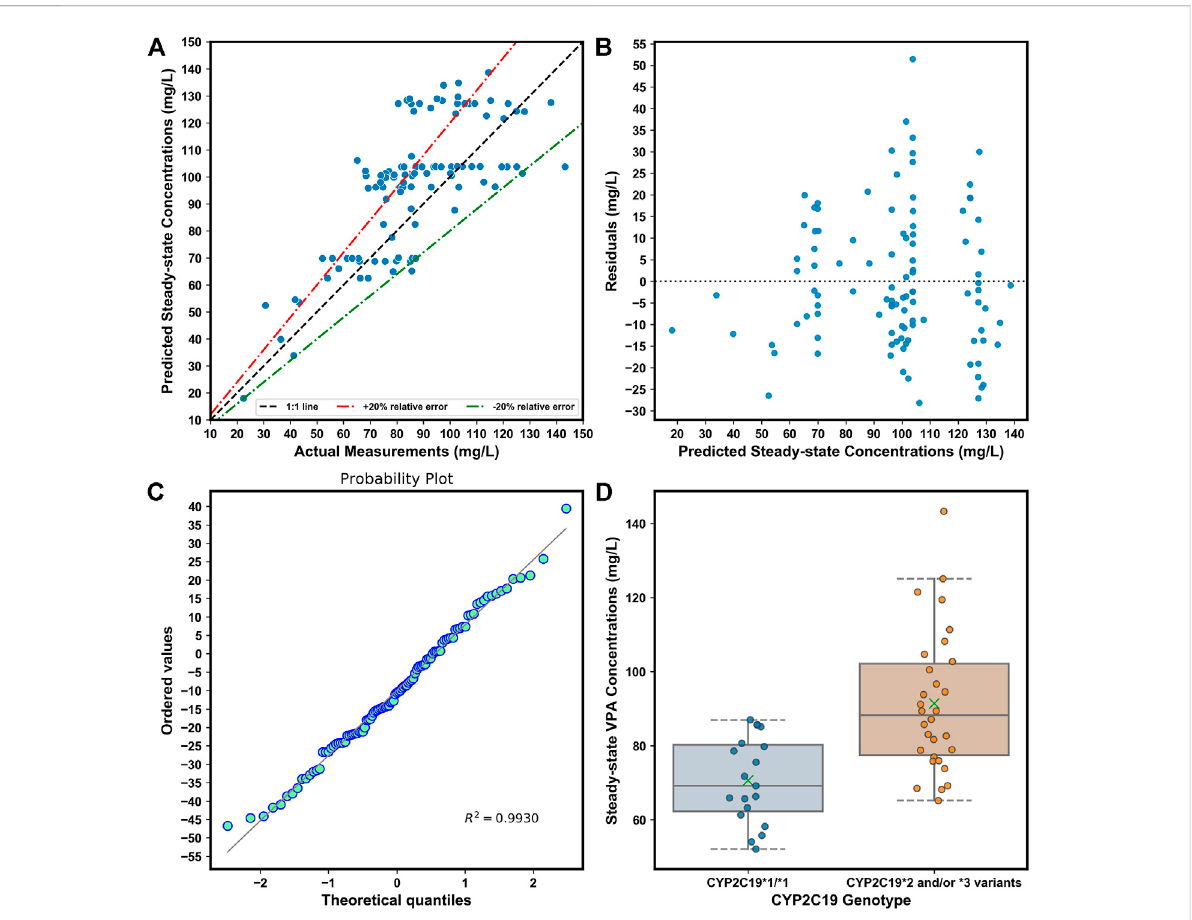
FIGURE 7 (A) . Comparison of predicted and observed C ss values of VPA on the independent external dataset based on the simpli fi ed optimum XGBoost model. The range between red and green dotted lines represents +20~-20% relative errors, i.e., the predicted values within ±20% of the observed values. (B) Residuals plot of residuals versus the predicted C ss values. (C) Probability plot of the residuals. (D) Comparison of observed C ss of VPA between patients with CYP2C19*1*1 genotype and CYP2C19*2 and/or *3 variants at a dosage regimen of 500 mg/bid on our independent external dataset. The green multiplication sign indicates the mean C ss values of